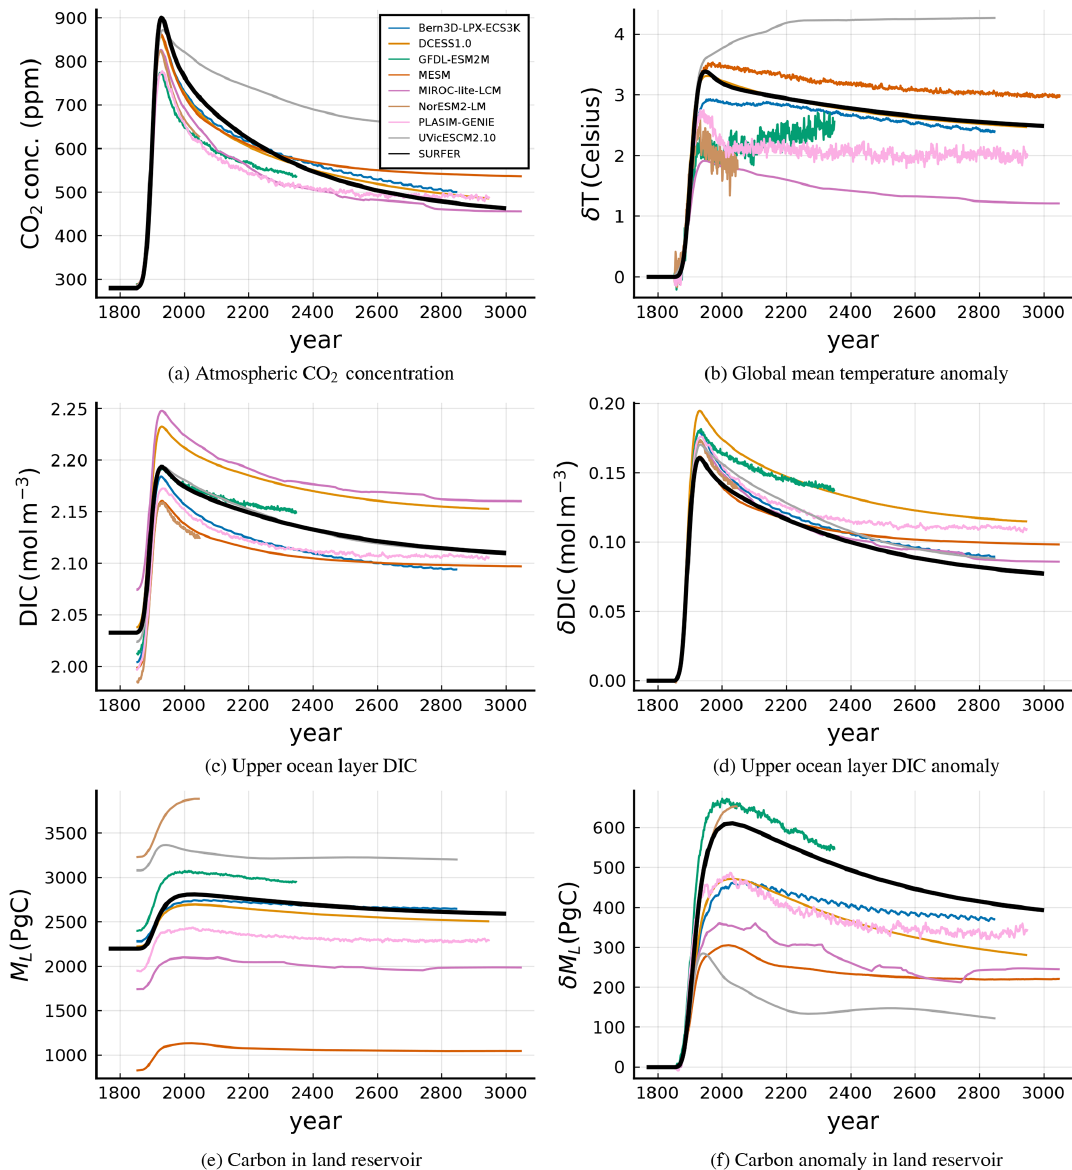
Figure 10. ZECMIP B3 experiment outputs of 6 EMICs, 2 ESMs and